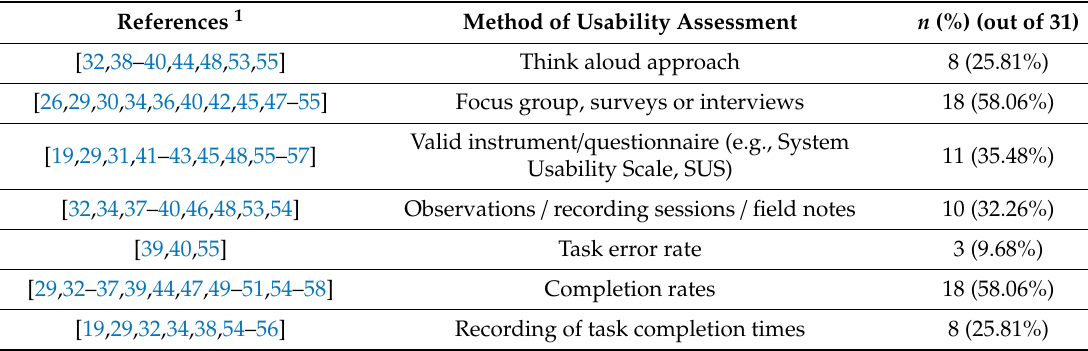
Table 1. Methods of usability assessment reported in the manuscripts included in this systematic review.